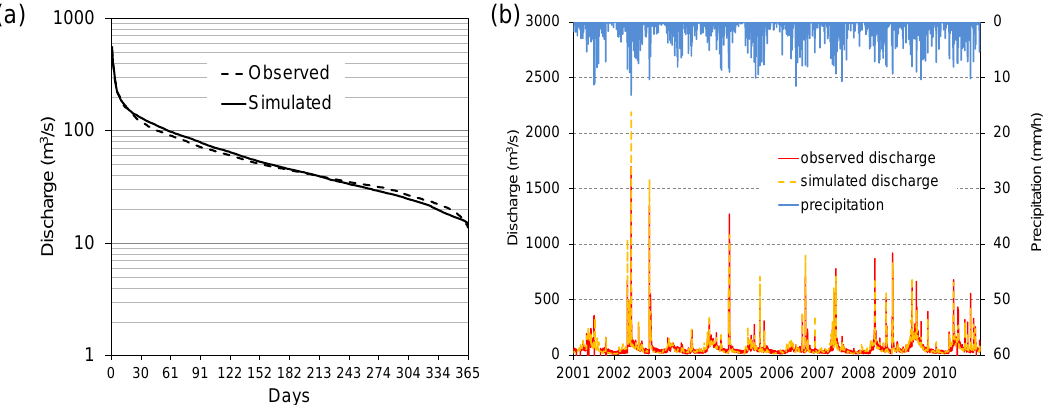
Figure 4. ( a ) Mean flow duration curve as derived from observed and simulated discharge; and ( b ) comparison between the simulated and observed hourly discharge at Candoglia section.